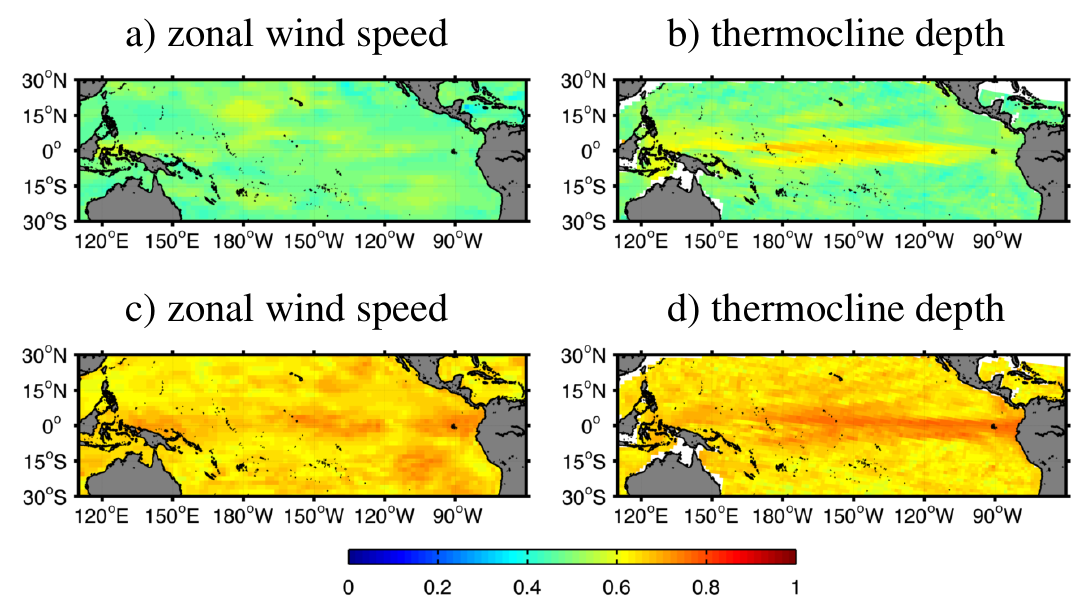
Fig. 6. Composite over 20:00 CT El Ni˜no events of the predictive power, PP of NINO3 remaining in June after assimilating SST from 110 ◦ W in JFM(0) and (at a given location) either (a) zonal wind speed and (b) the thermocline depth. The same for the lower panels but now for the PP of NINO4 remaining in August after assimilating SST at 140 ◦ W in MAM(0) and either (c) zonal wind speed and (d) the thermocline depth.